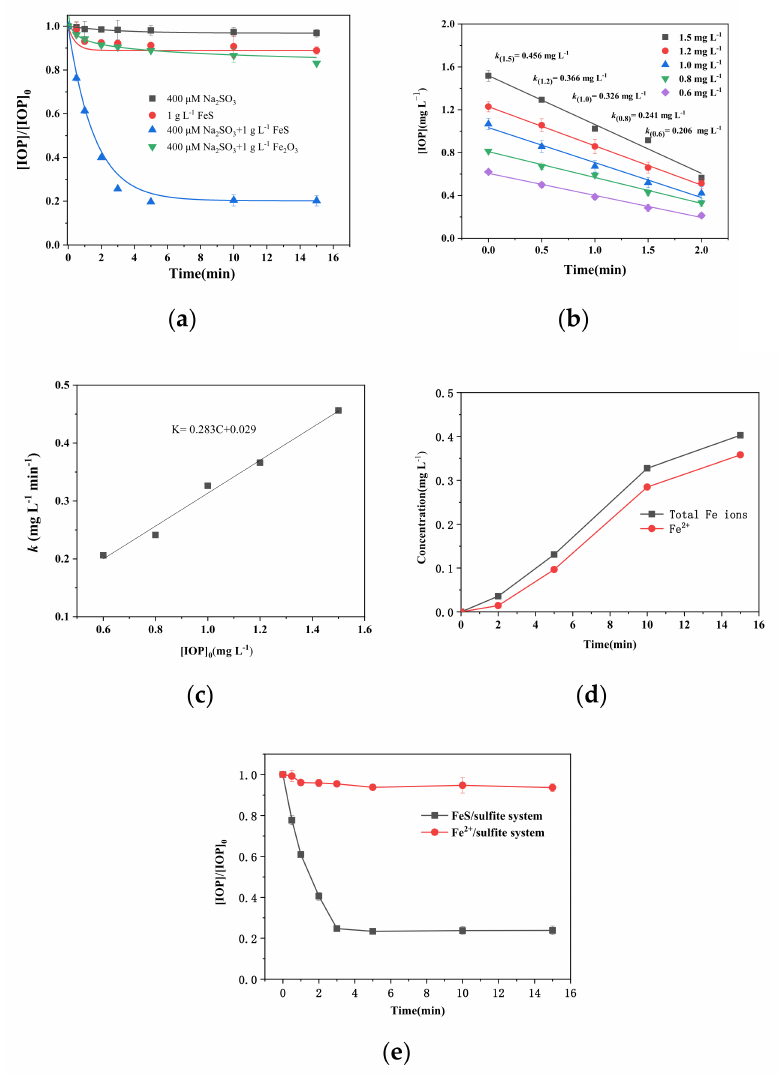
Figure 2. ( a ) Concentration changes of IOP in the control experiments by FeS/sulfite systems. ( b ) The effects of initial IOP concentrations. ( c ) Pseudo-first-order kinetics. ( d ) The concentration changes of total Fe ions and Fe 2+ in FeS/sulfite system. ( e ) Degradation of IOP by Fe 2+ /sulfite system and FeS/sulfite system. Conditions: [IOP] 0 = 1.5 mg L − 1 , [FeS] 0 = [Fe 2 O 3 ] 0 = 1 g L − 1 , Fe 2+ = 0.4 mg L − 1 [Na 2 SO 3 ] 0 = 400 µ mol L − 1 , pH init =